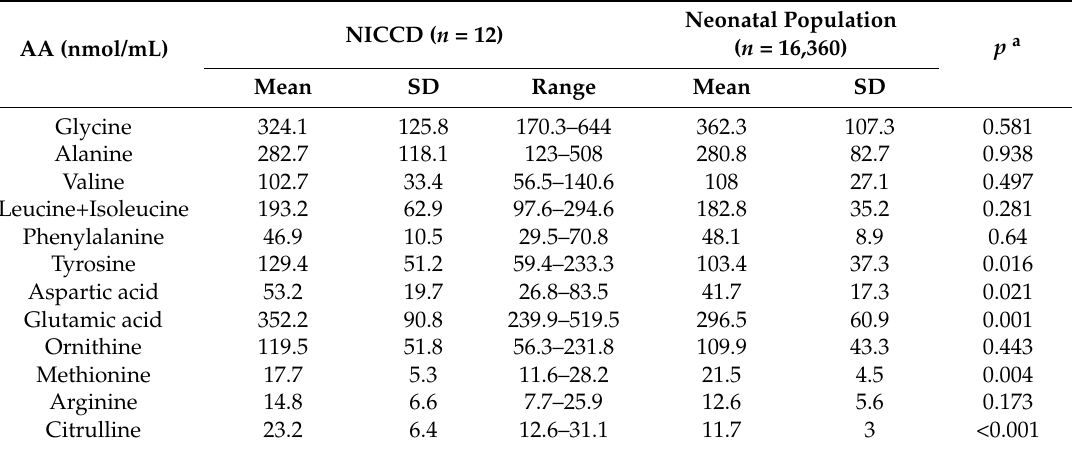
Table 2. Aminogram of missed patients with NICCD.